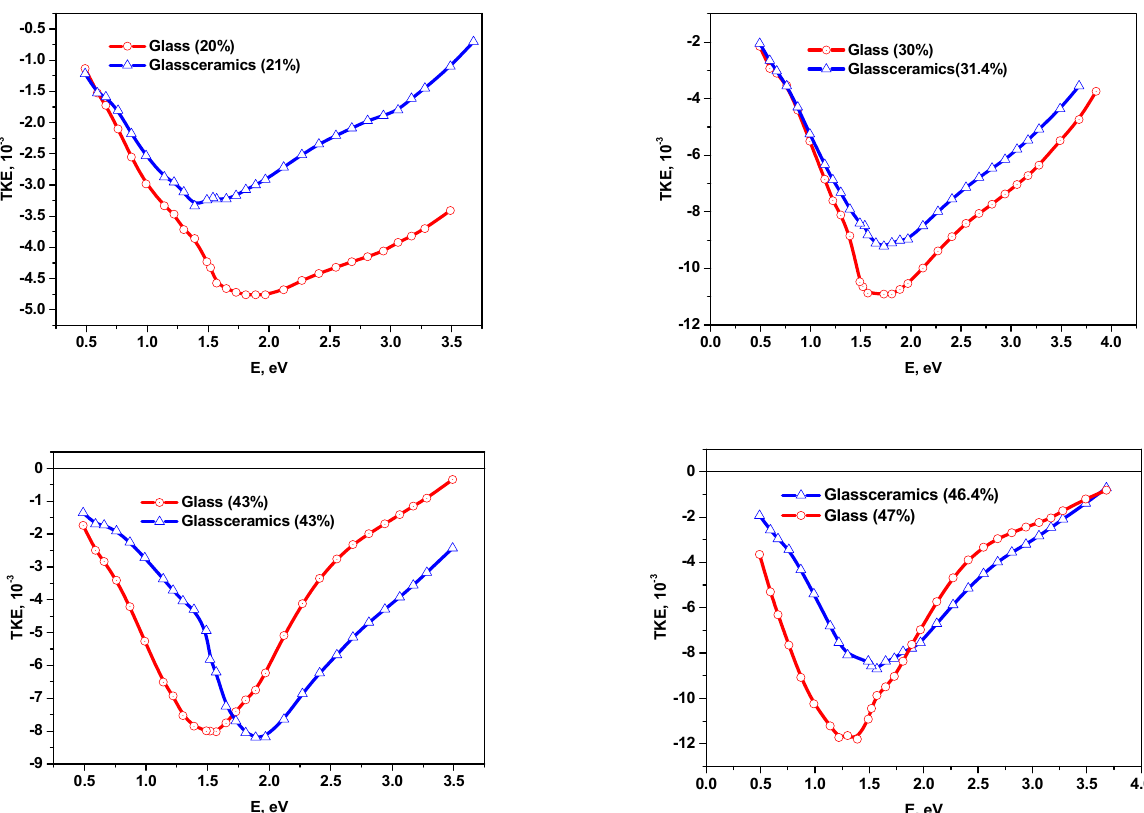
Figure 10. Comparison of the spectral dependences of TKE for nanocomposites (CoFeZr) x (MgF 2 ) 100 − x on glass and glass-ceramics substrates.